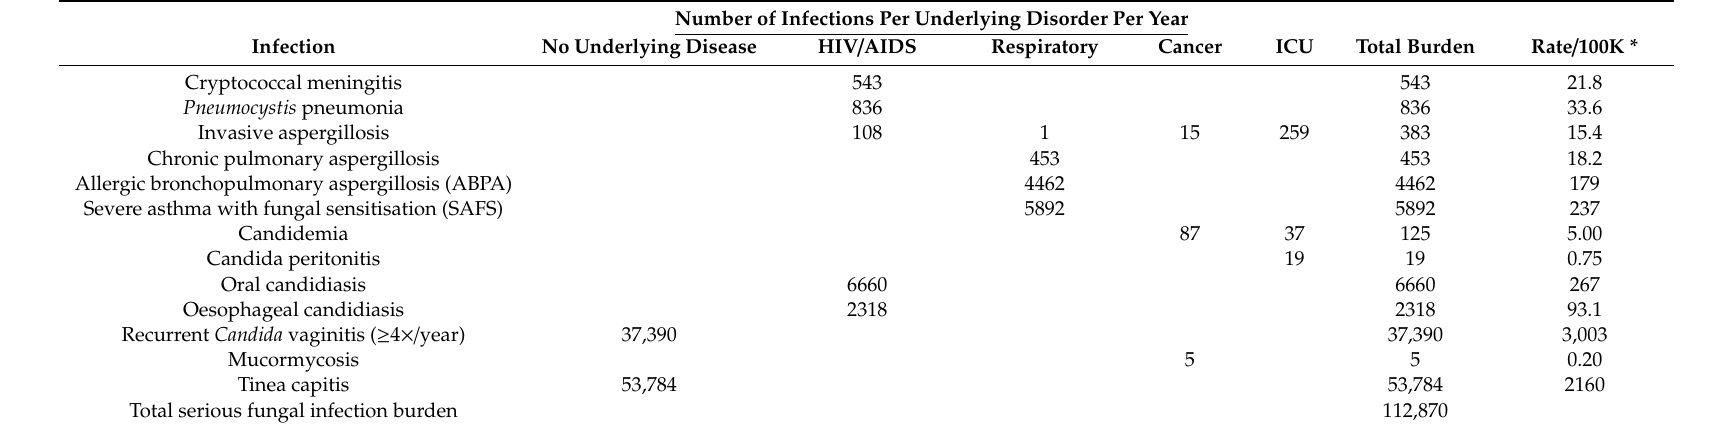
Table 1. Estimated burden of serious fungal infections in